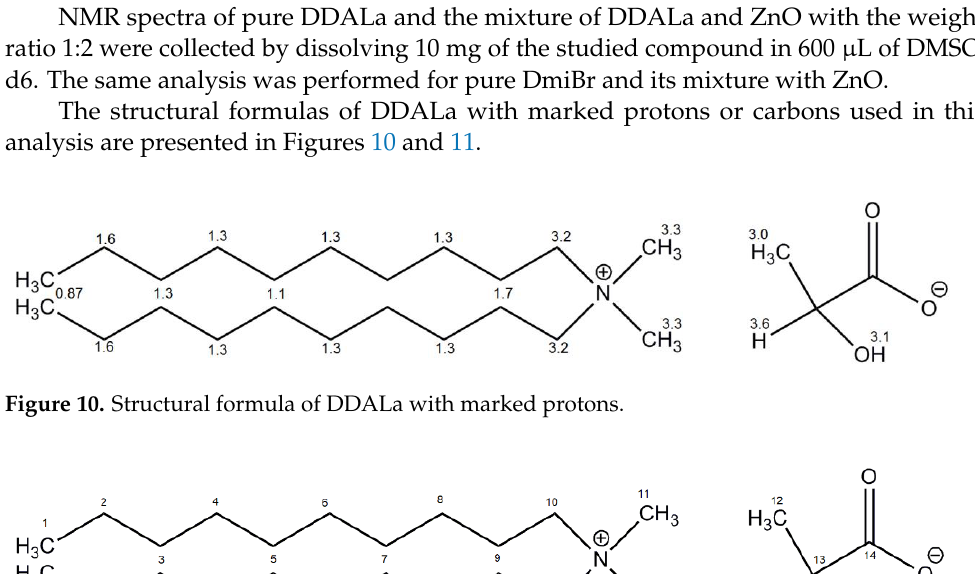
Figure 12. 1 H Nuclear Magnetic Resonance (NMR) spectrum for pure DDALa. ( a ) ( b ) Figure 13. 13 C NMR spectra: ( a ) pure DDALa; ( b ) 1:2 mixture of DDALa and ZnO.